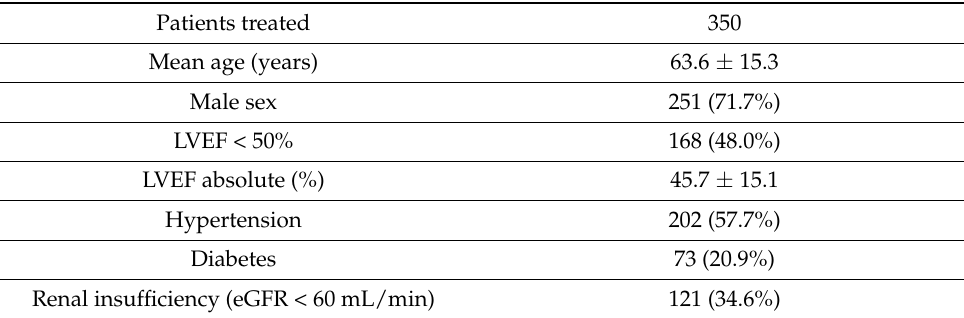
Table 2. Patient, procedure, and lead